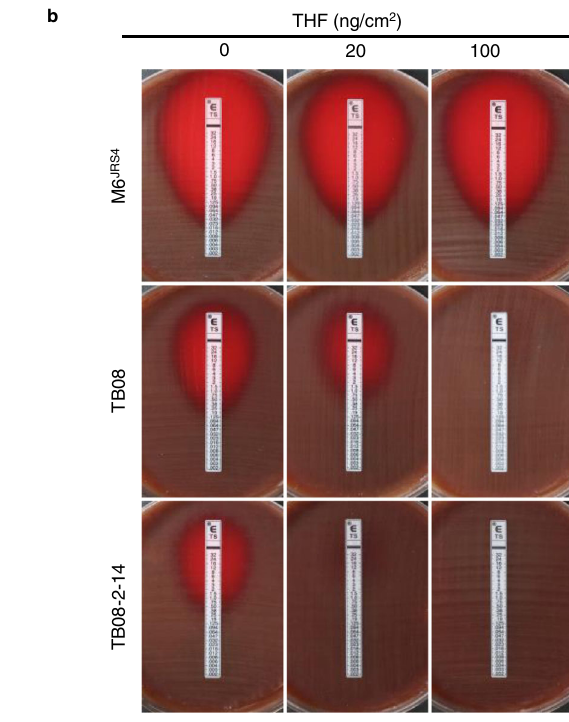
Fig. 3 | ThfT confers SXT resistance in the presence of exogenous THF. a Dose- responsecurvesfortheimpactofexogenousTHFonSXTresistanceofM6 JRS4 ,TB08 andTB08-2-14.MICsareexpressedasapercentagethemaximumresolutionofthe Etest assay (32 μ g/ml). Data from three biological replicates on MHF-Bm agar are presented as meanvalues ± SD. EC 50 values were calculated using Graphpad Prism software. b Representative Etest assays on MHF-Bm agar for data presented in a . c SchematicshowingpredictedeffectofincreasedThfTexpressioninTB08-2-14on